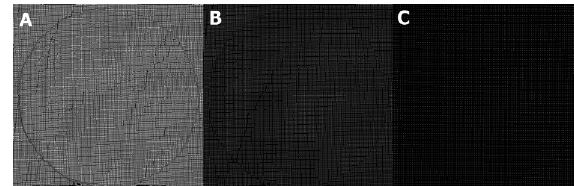
Fig ure 11. Point clouds of the test object, colour by classification acquire from a 10 m distance, with resolution